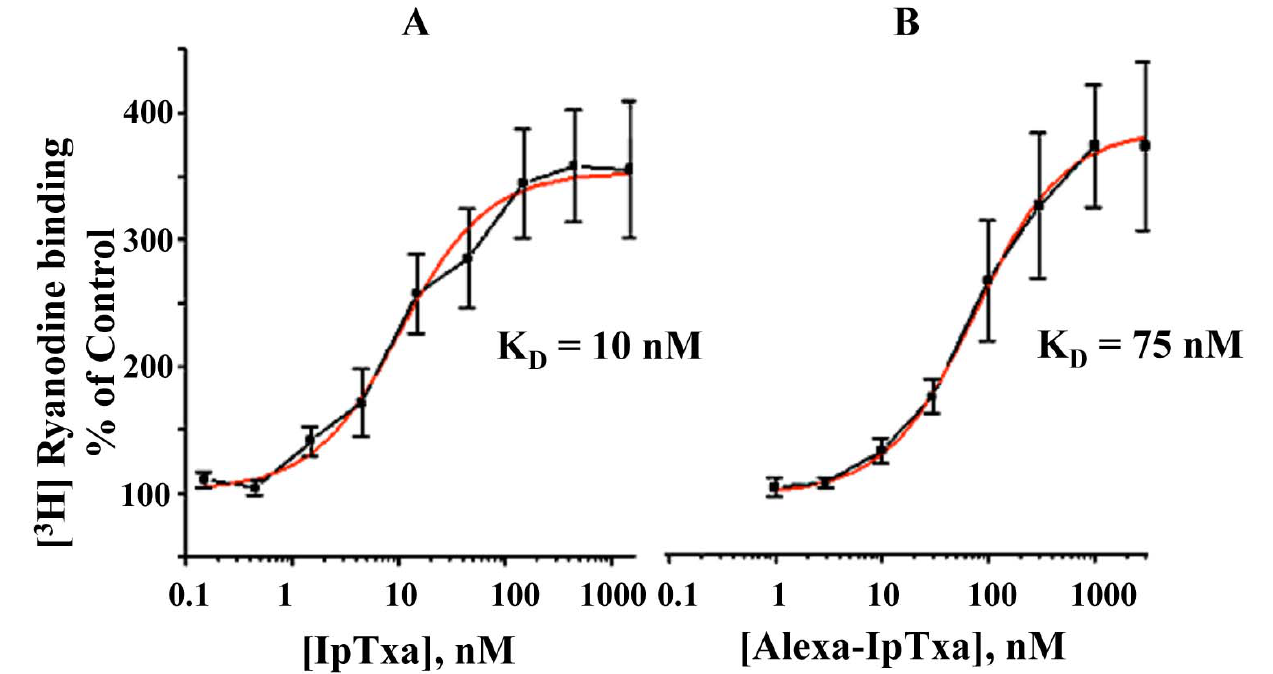
Figure 5. Dose-dependent activation of [ 3 H]-ryanodine binding by native IpTxa and Alexa-IpTxa. Skeletal SR vesicles were incubated with 7 nM [ 3 H]ryanodine in the absence (control 100%) and the indicated concentration of native (B) or modified IpTxa (A) The binding reaction was carried out for 90 min at 36 ˚ C in medium containing 0.2 M KCl, . Free and bound ligand were separated by 10 mM Na-HEPES (pH 7.2) and 10 μ M CaCl 2 rapid filtration as described in methods. Results are the mean ± S.D. of n=4 independent